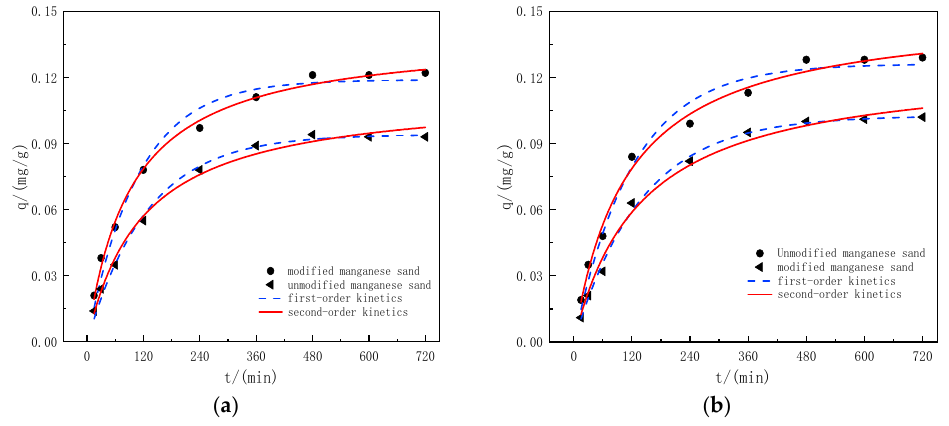
Figure 9. The adsorption kinetic model of iron ( a ) and manganese ( b ) ions.